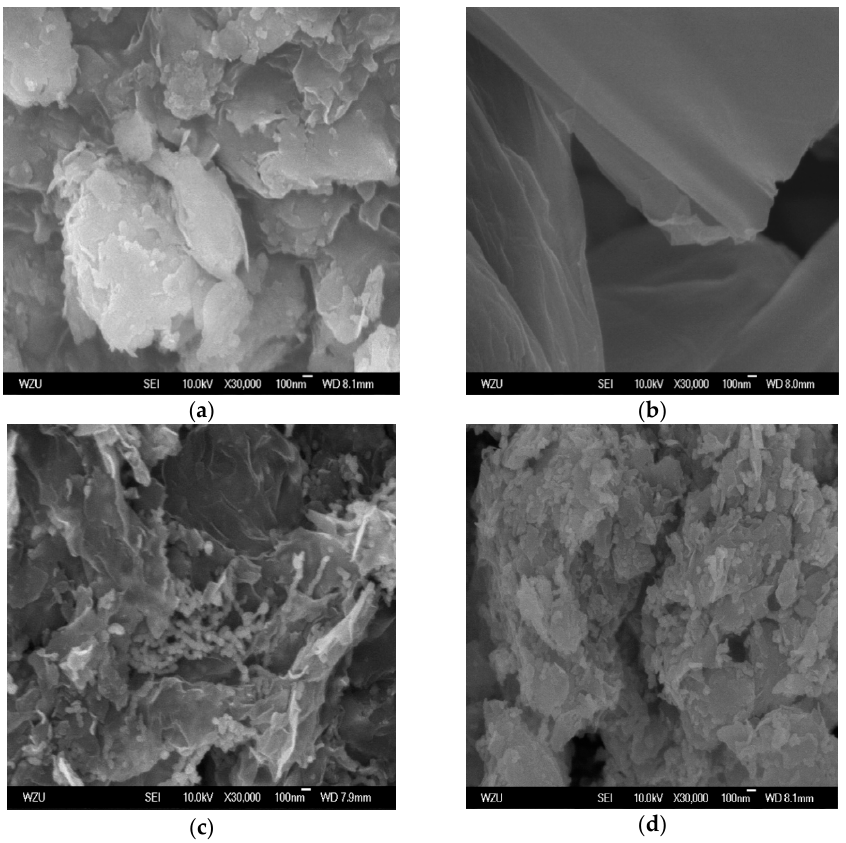
Figure 3. Scanning electron microscope (SEM) images of ( a ) bentonite, ( b ) GO, ( c ) B-nZVI, and ( d ) GO-B-nZVI.